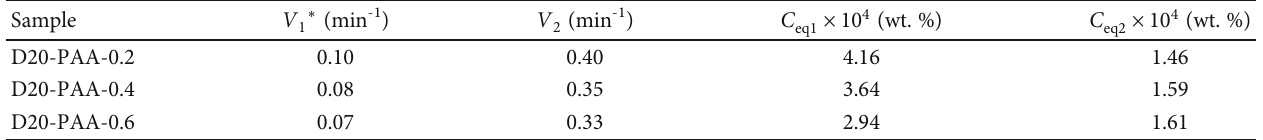
Table 1: Di ff usion rate of dye and equilibrium dye concentration at sorption of methylene blue by hydrogel.